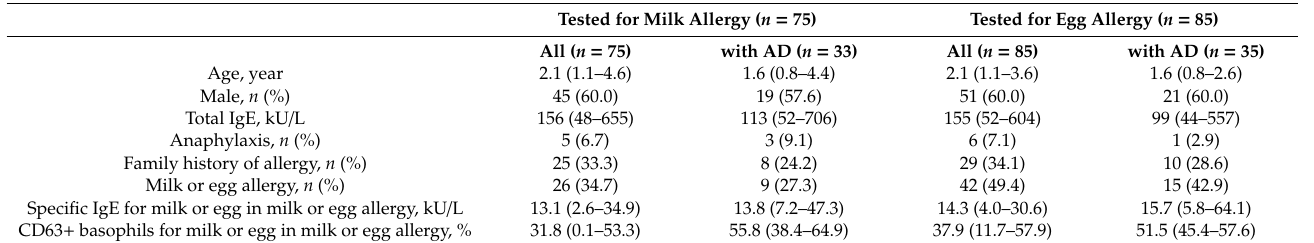
Table 2. Comparison of subjects’ characteristics between total subjects and subjects with